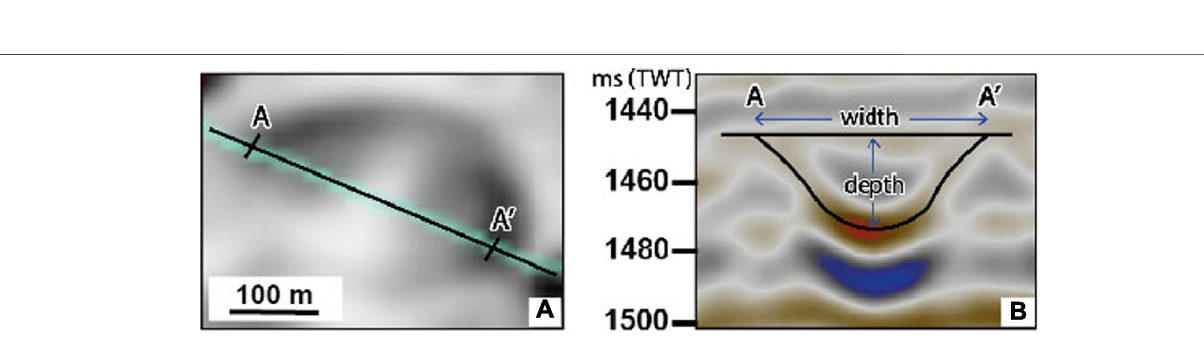
FIGURE7|(A) Un-interpreted and (B) interpreted3Dseismicpro fi lesshowpaleo-pockmarks(PM)above abasin fl oorfanand polygonalfaultsinvery fi ne-grained sedimentary successions above a progradational delta. See seismic pro fi le location in Figure 6 .